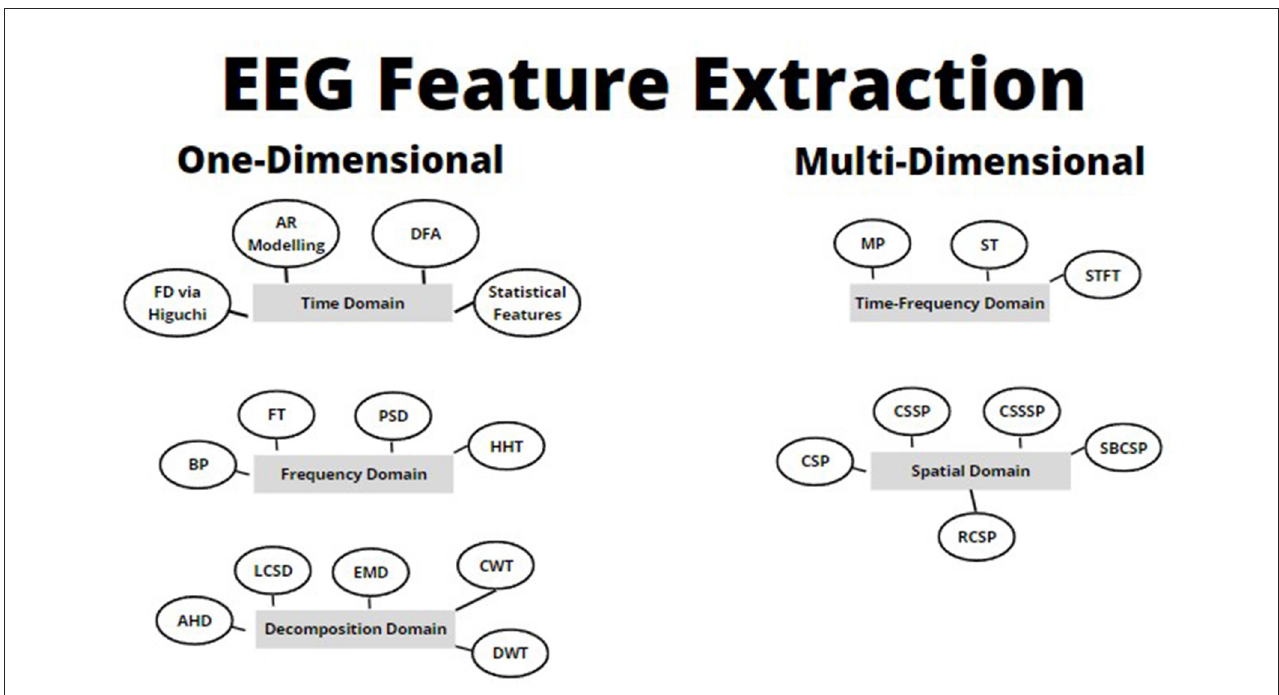
FIGURE8 Summary of EEG feature extraction